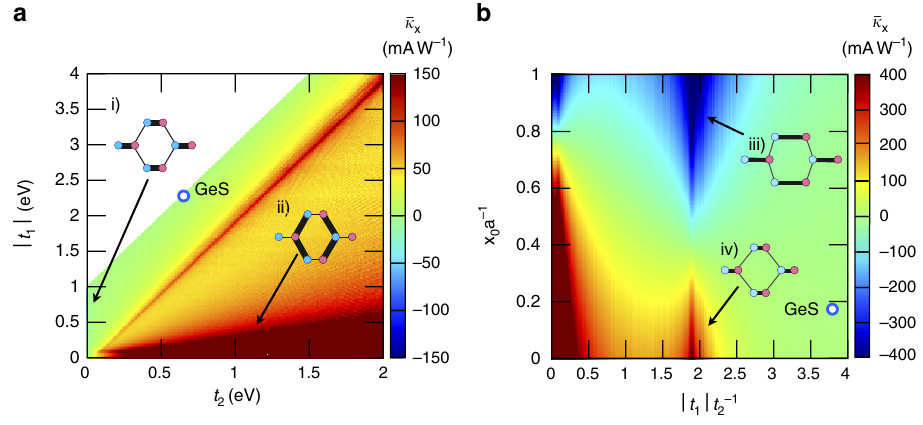
Figure 3 | Phase diagrams for monochalcogenide layer tight-binding model. ( a ) Polarization-averaged photoresponsivity in the x -direction, ~ k x , at the band gap frequency plotted as a function of hopping parameters | t 1 | and t 2 , keeping the band gap fixed at 1.89eV by tuning D accordingly. The Ge-S distance is x 0 ¼ 0.52Å and t 3 ¼ 0. The location of GeS on the phase diagram is marked by a white circle with blue outline. Regions for which the gap cannot be kept at 1.89eV are left white. (i) and (ii) show bond strengths in the limits where t 1 j j (cid:9) t 2 and t 1 j j (cid:4) t 2 , respectively, to illustrate the two extremes of the phase diagram. ( b ) Polarization-averaged photoresponsivity in the x -direction, ~ k x , at the band gap frequency plotted as a function of the Ge-S distance x 0 in units (cid:4) (cid:5) 1 = 2 and ratio of hopping parameters | t of a ¼ a 2 a 2 1 |/ t 2 . Here, D and t 2 are set to GeS values of 1.1 and 0.61eV, respectively. The location of GeS on the 1 þ 2 phase diagram is marked by a white circle with blue outline. (iii) and (iv) show two extreme cases of the phase diagram, where x 0 is large and small,